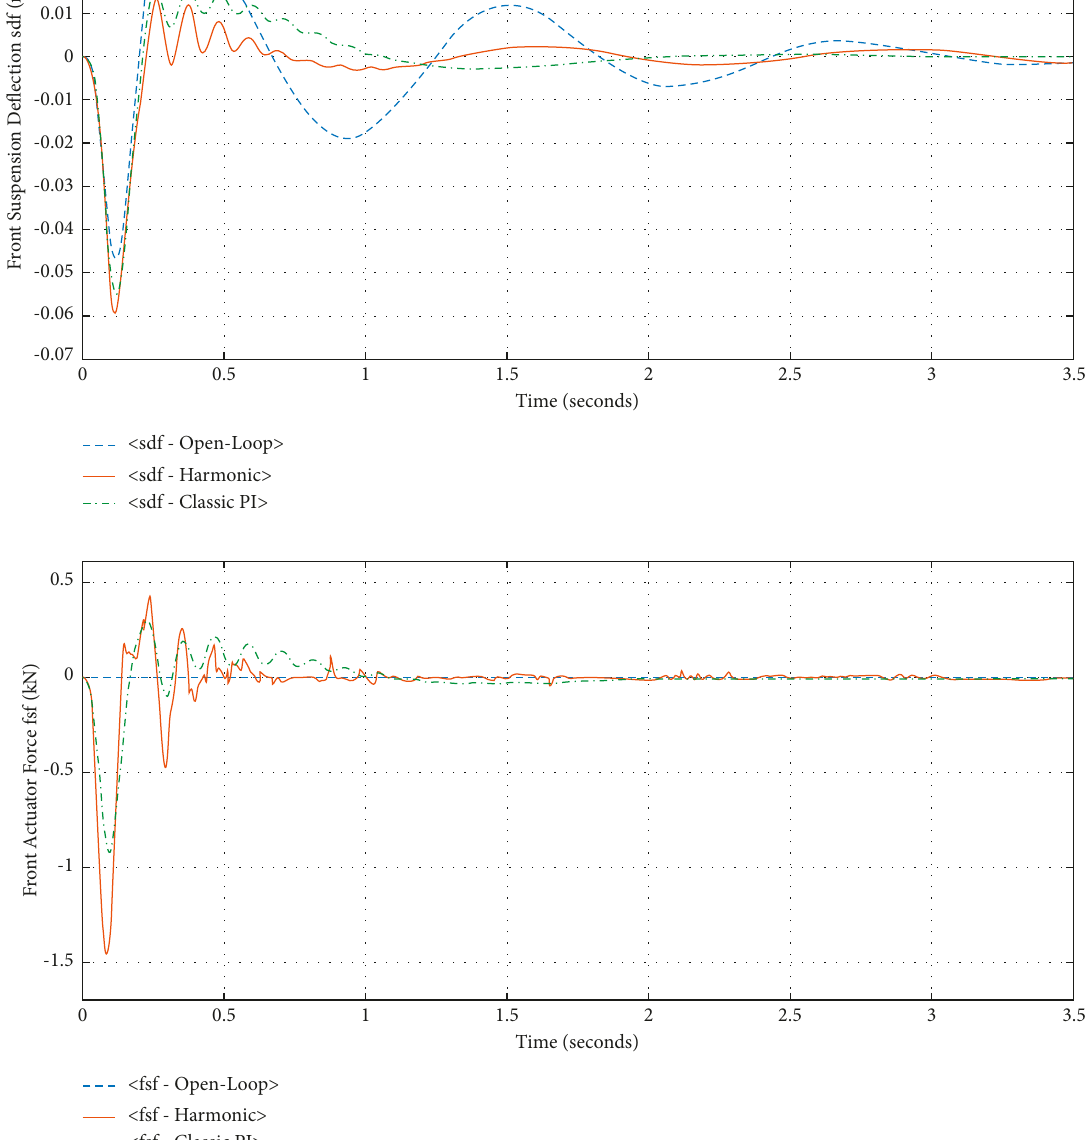
Figure 6: Front suspension deflection s harmonic, and green dash line means classic